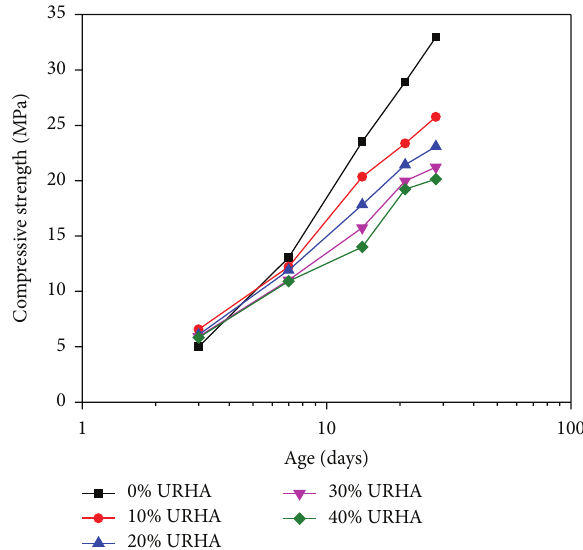
Figure 5: Strength development of brick samples at different URHA replacement